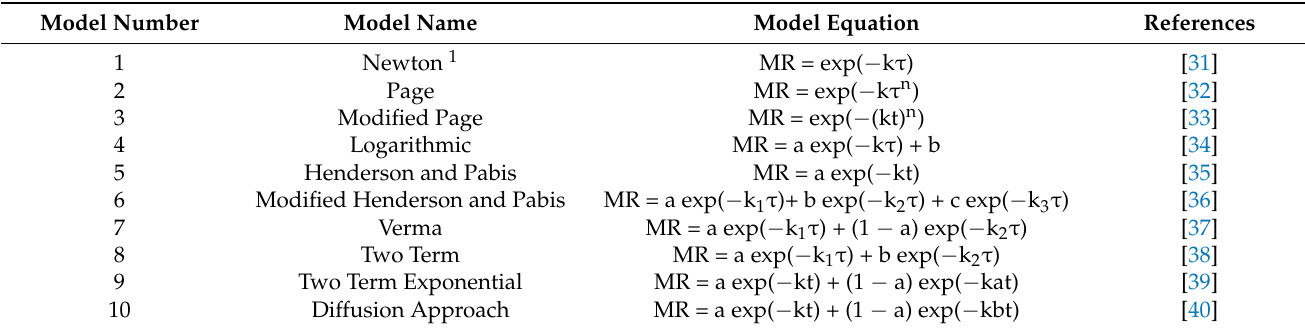
Table 1. Mathematical models applied to hot air drying